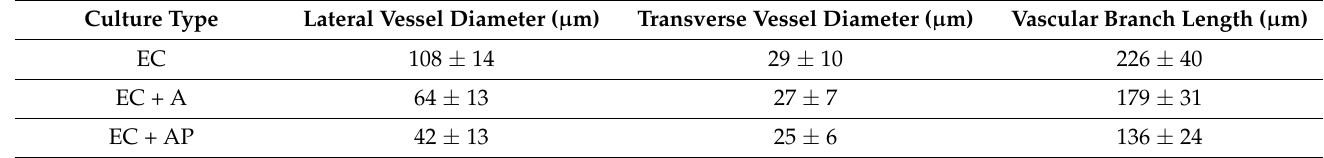
Table 3. Vessel diameters of 3D microfluidic BBB